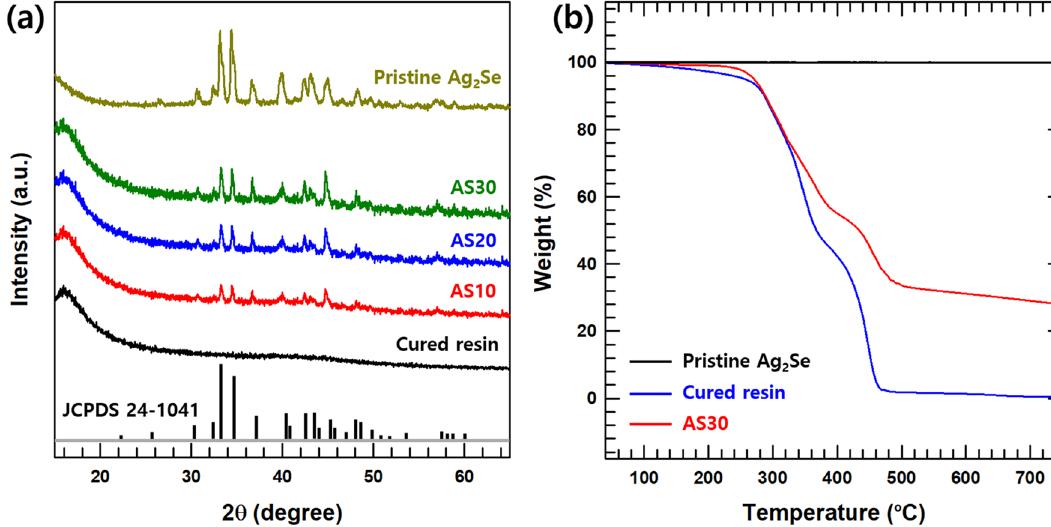
Figure 2. ( a ) XRD patterns of cured resin, AS10, AS20, AS30, and pristine Ag 2 Se. ( b ) TGA curves for pristine Ag 2 Se, cured resin and AS30 under N 2